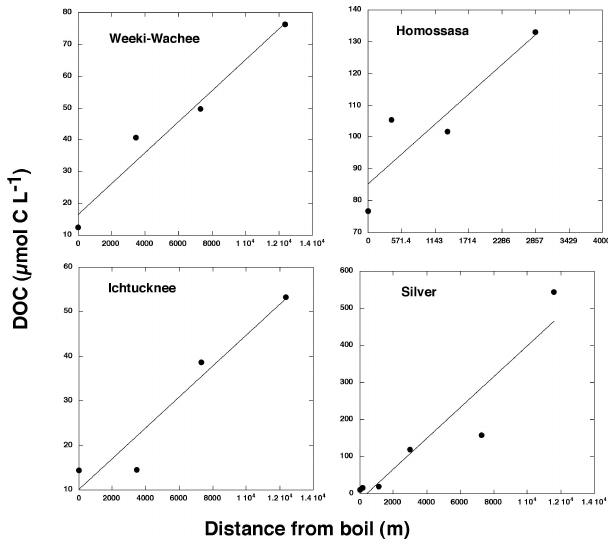
Fig. 2. The relationship between dissolved organic carbon (DOC) concentrations and distance from the point of surgence of ground- water in Weeki Wachee, Homosassa, Ichetucknee, and Silver springs. The solid lines show the fitted least squares regres- sion equations; Weeki Wachee: DOC (µmolCL − 1 ) = 16.5 + 0.0048 Distance (m), R 2 = 0 . 96; Homosassa: DOC (µmolCL − 1 ) = 85.3 + 0.0016 Distance (m), R 2 = 0 . 81; Ichetucknee: